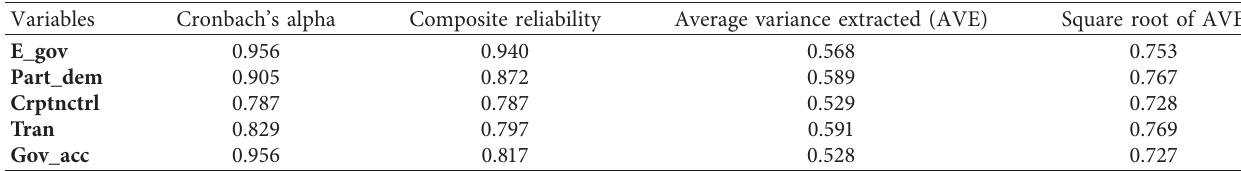
Table 4: Cronbach’s alpha, composite reliability, and average variance extracted (AVE).